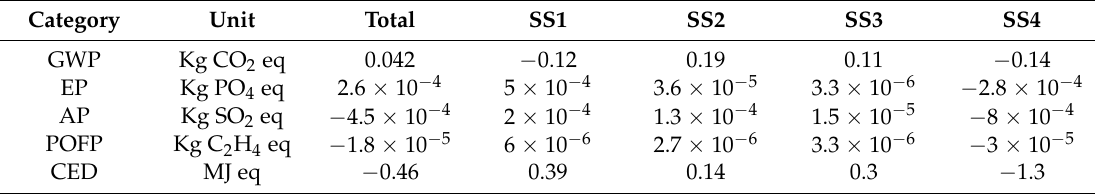
Table 7. Characterization results corresponding to the production of 1 MJ H2